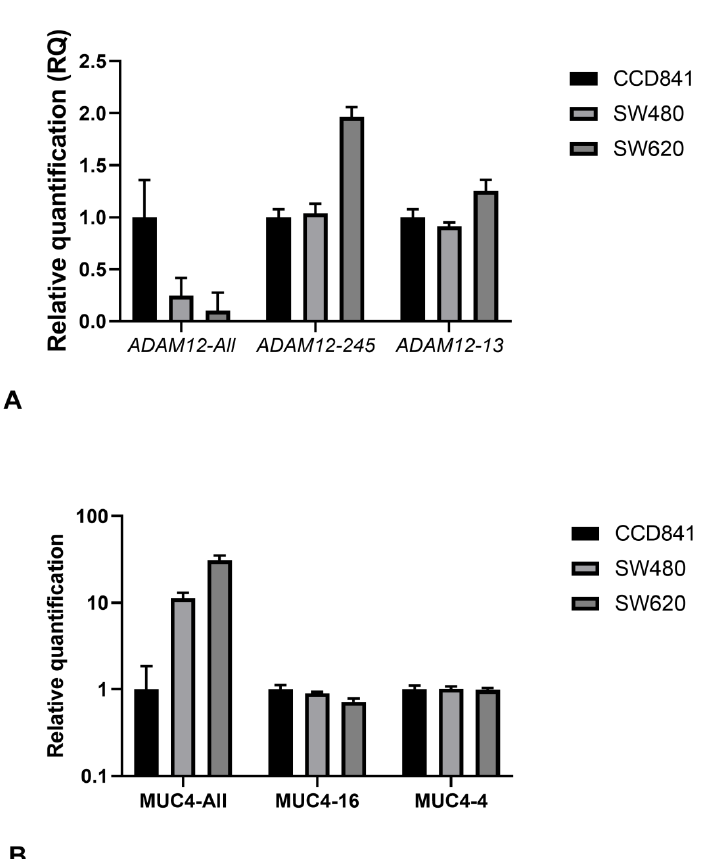
Figure 5. Quantification of the expression of ADAM12 and MUC4 isoforms in cell lines. Quanti- tative RT-PCR analyses indicated the differential expression of the isoforms of ADAM12 and MUC4 in normal colon (CCD841) cells and primary (SW480) and metastatic (SW620) CRC cell lines. ( A ) The trend for ADAM12 -All amplicon expression was CCD841 > SW480 > SW620, whereas the trend for ADAM12-245 amplicon expression was CCD841 = SW480 > SW620. A similar trend was observed for the ADAM12-13 primers. ( B ) MUC4 -All showed an increasing pattern from normal to metastatic cells, whereas no differences in the MUC4-16 and MUC4-4 amplicons were observed between the cell lines.